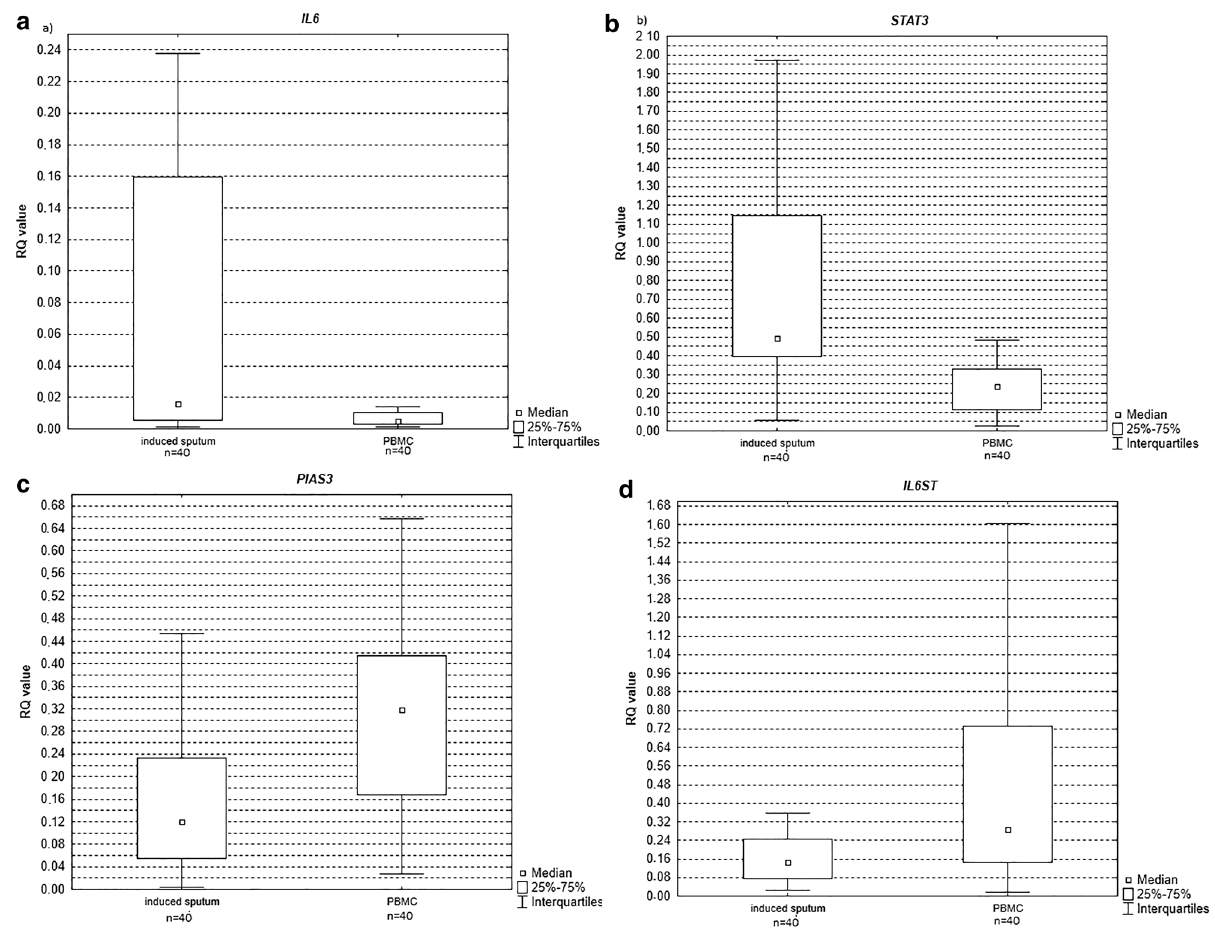
Figure 5. Box-and-whisker plots representing the expression value (median RQ value) of ( a ) IL-6 ( p = 0.0003) ( b ) STAT3 ( p = 0.000001) ( c ) PIAS3 ( p = 0.006) ( d ) IL6ST ( p = 0.002) in induced sputum versus PB lymphocytes in COPD